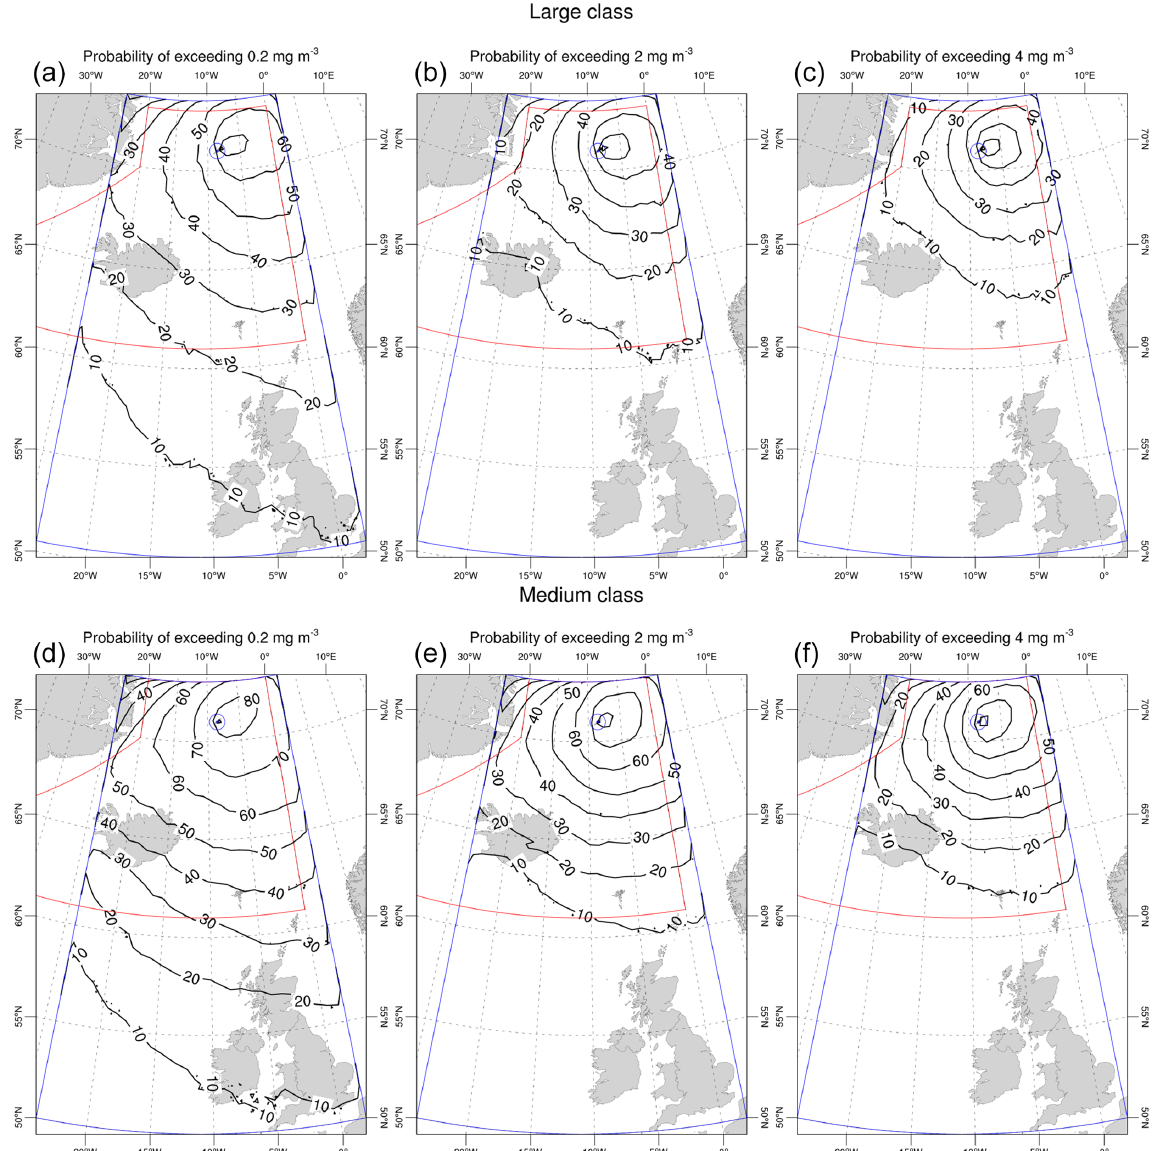
Figure 9. Exceedance probability maps at FL050: the isolines show the probability of reaching an ash concentration above 0.2mgm − 3 (a, d) , 2mgm − 3 (b, e) , and 4mgm − 3 (c, f) at FL050 at some time from the onset of the eruption to up to 48h after its end. The three upper plots apply to the large class and the three at the bottom to the medium